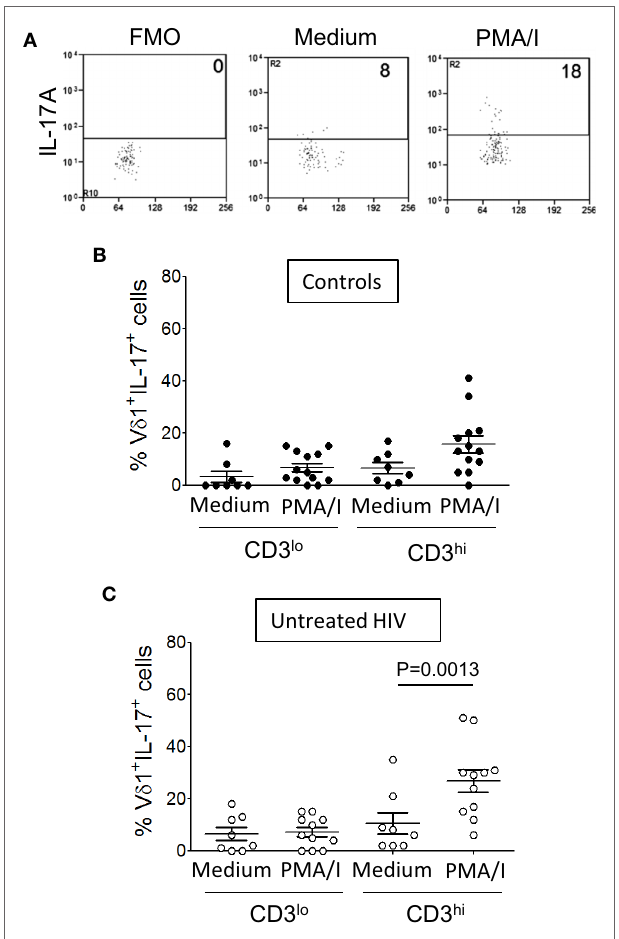
FigUre 8 | CD3 ε lo V δ 1 T cells exhibit impaired interleukin (IL)-17 production. Peripheral blood mononuclear cell (PBMC) from 13 healthy donors and 11 patients with untreated human immunodeficiency virus (HIV) infection were enriched for γδ T cells using magnetic bead separation. The cells were stimulated for 6 h with phorbol myristate acetate with ionomycin (PMA/I) or incubated in medium alone in the presence of brefeldin A. (a) Flow cytometry dot plots showing IL-17A expression by gated CD3 ε hi V δ 1 T cells within unstimulated PBMC (center panel) and PMA/ionomycin-stimulated PBMC (right panel) from a patient with HIV. The left panel shows a fluorescence minus one (FMO) control dot plot. (B,c) Scatter plots show the frequencies of CD3 ε lo and CD3 ε hi V δ 1 T cells from healthy donors (B) and HIV patients (c) that produced IL-17. Groups were compared using the Mann–Whitney U